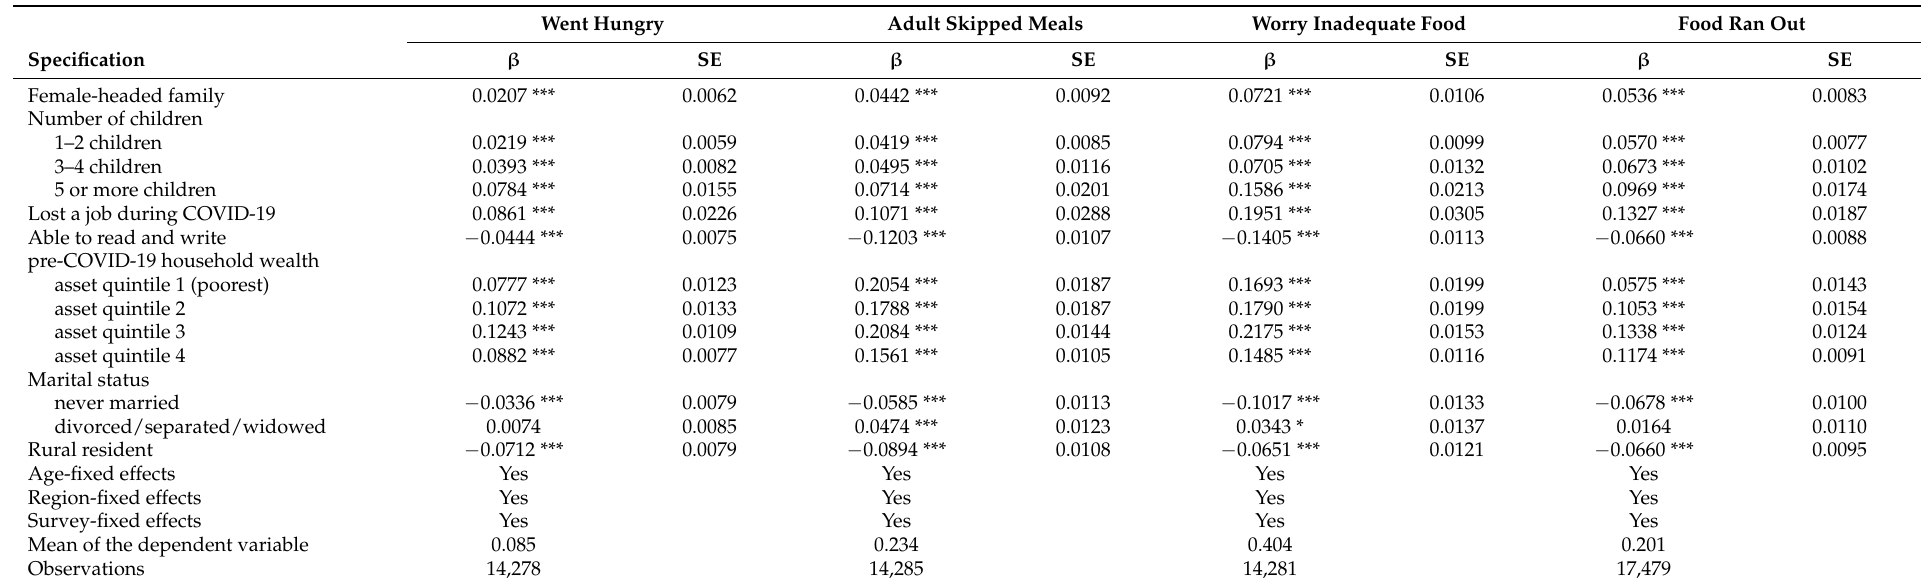
Table 4. Relationship between household structure and livelihood outcomes linked to food insecurity in